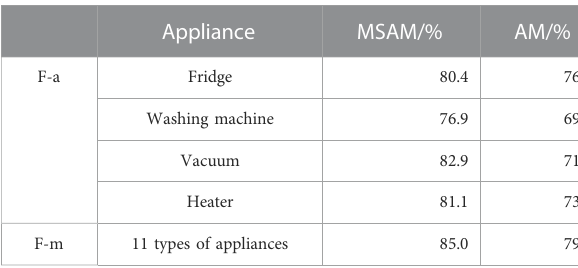
TABLE 2 Identi fi cation effect of different attention